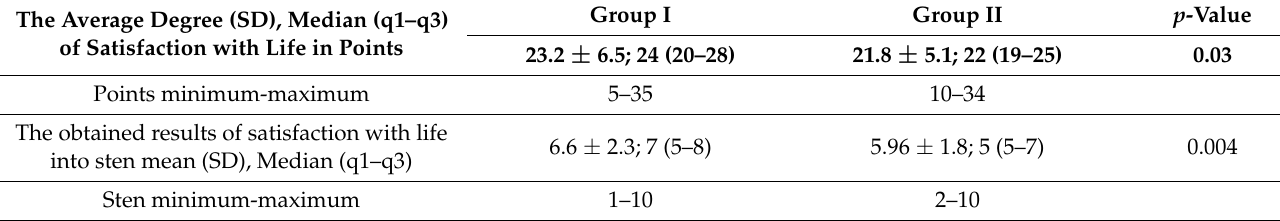
Table 2. Results of the Satisfaction with Life Scale (SWLS) of young people and seniors.